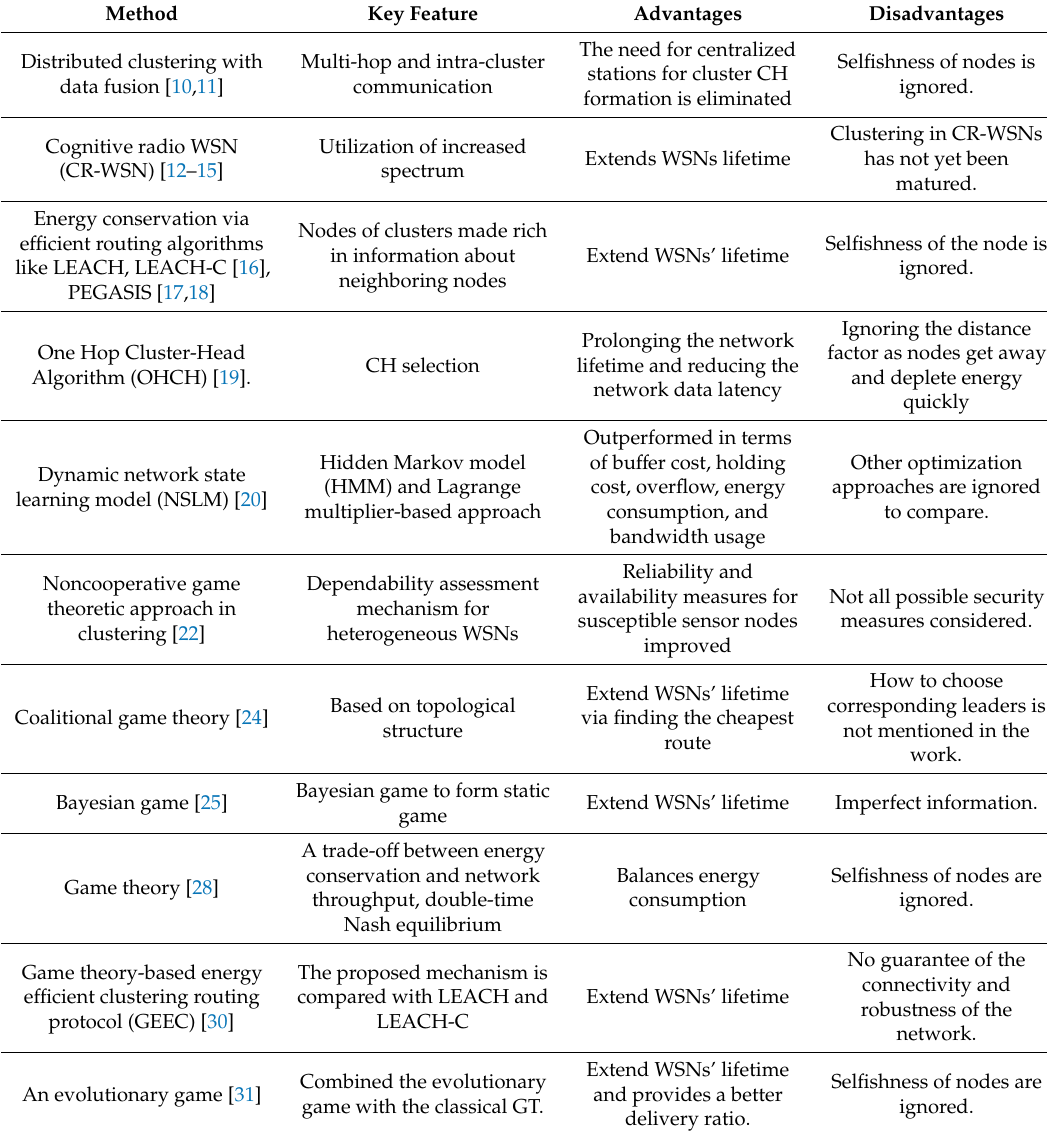
Table 1. Comparison of advantages and disadvantages of related